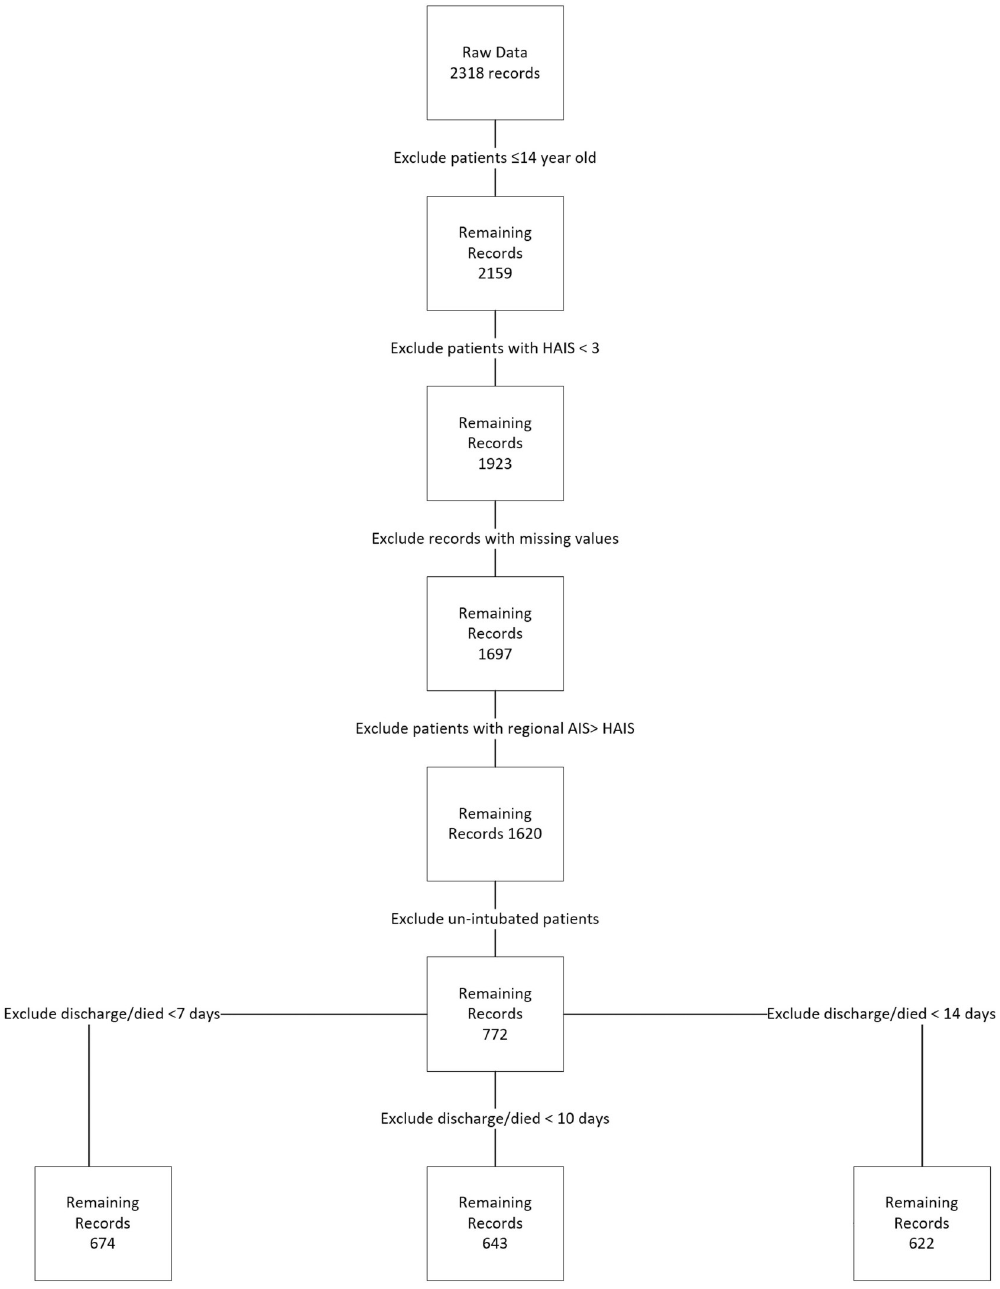
Fig 2. Records inclusion and exclusion